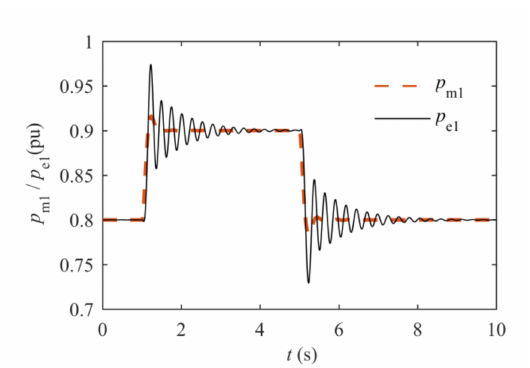
Figure 3. Diesel engine torque, p m 1 , and generator electromagnetic power, p e1 ,